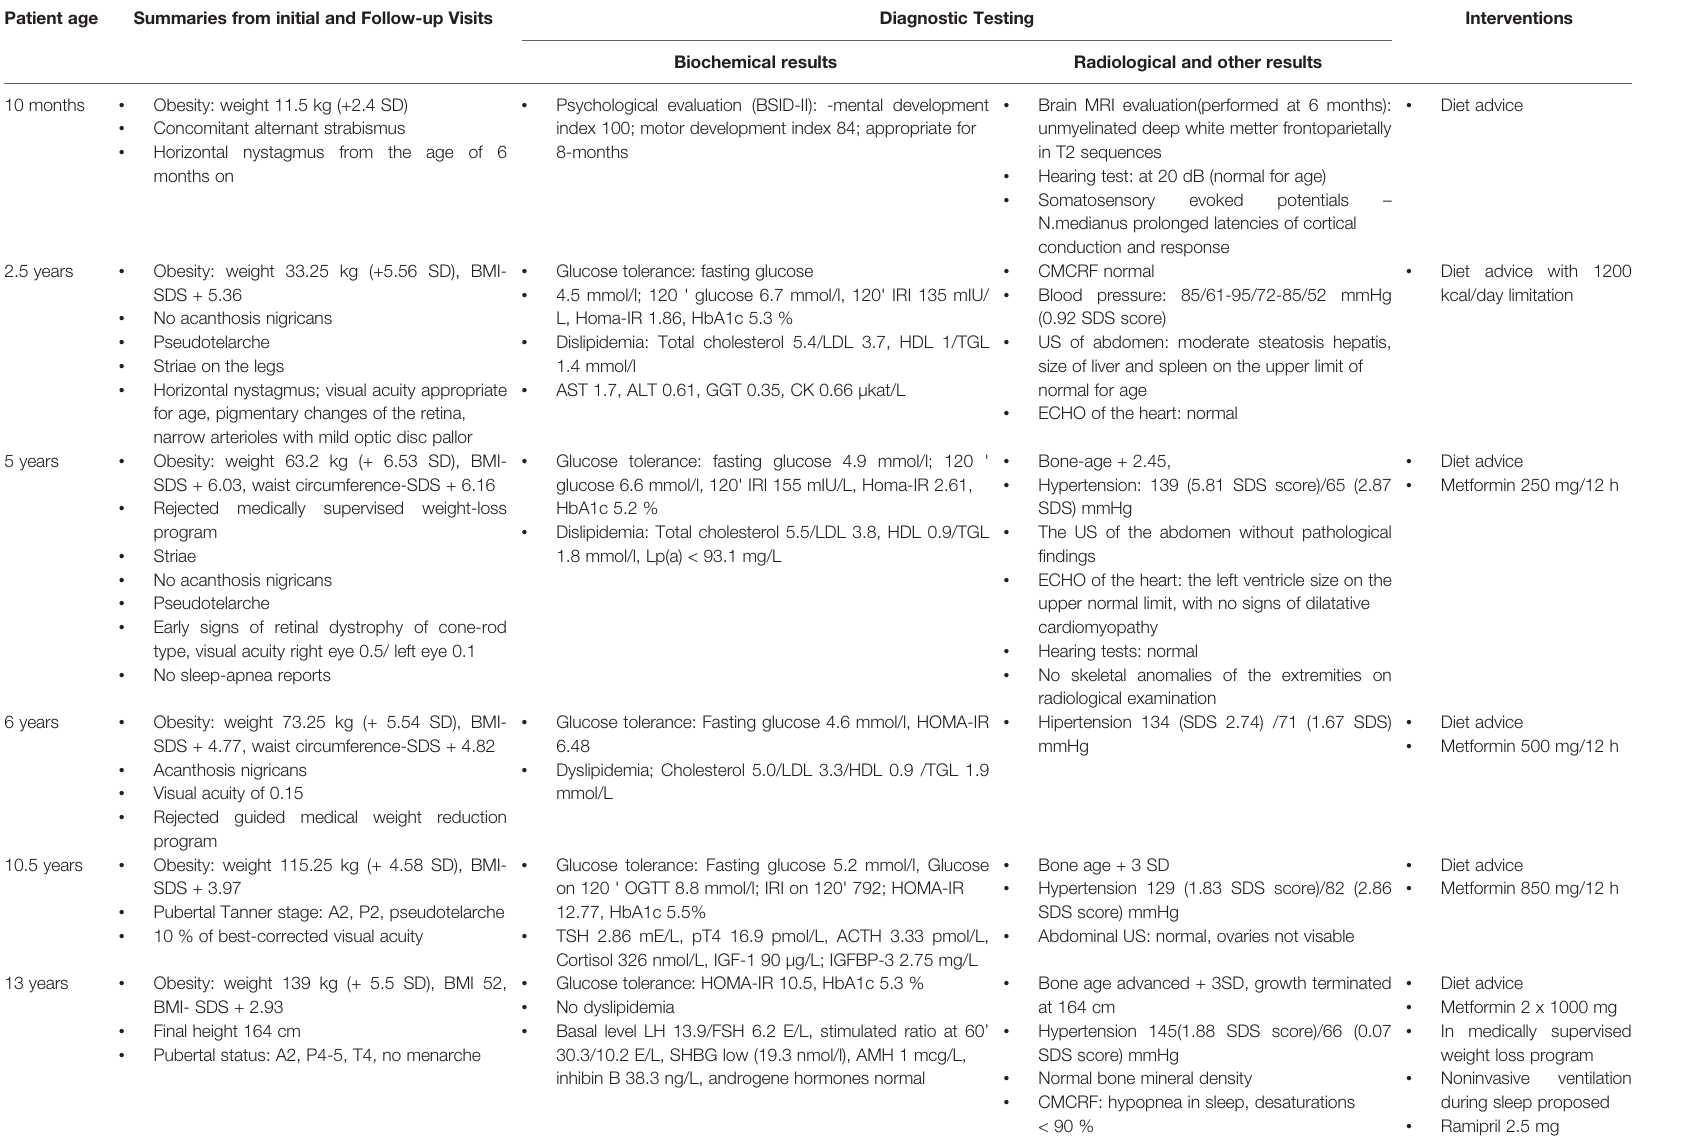
TABLE 1 | Timeline of clinical fi ndings, Diagnostic tests, and Interventions. Patient age Summaries from initial and Follow-up